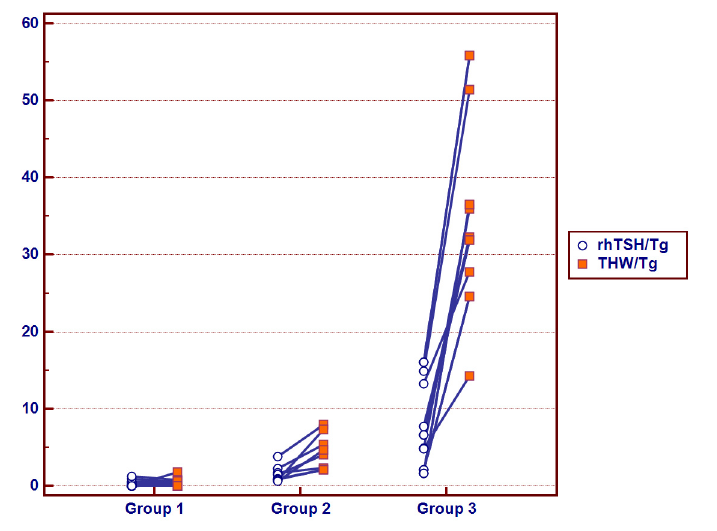
Fig 1. Recombinant human thyrotropin-stimulated thyroglobulin (rhTSH/Tg) and thyroid hormone withdrawal-stimulated thyroglobulin (THW/Tg) in the same patients in three groups: Group 1-